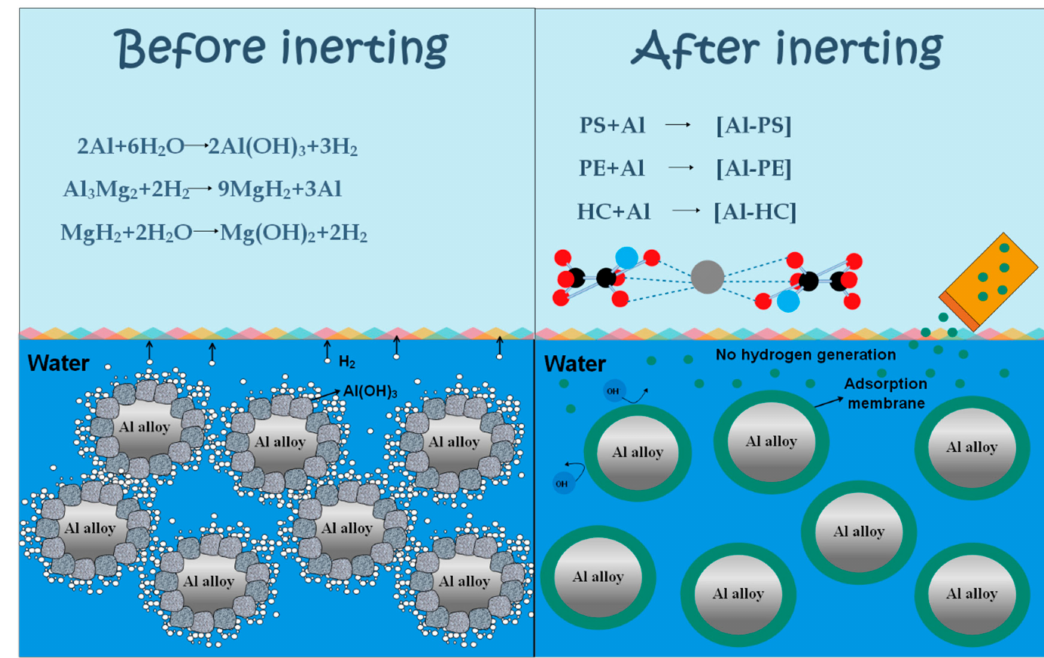
Figure 9. Inhibition mechanism of PS, PE, and HC.